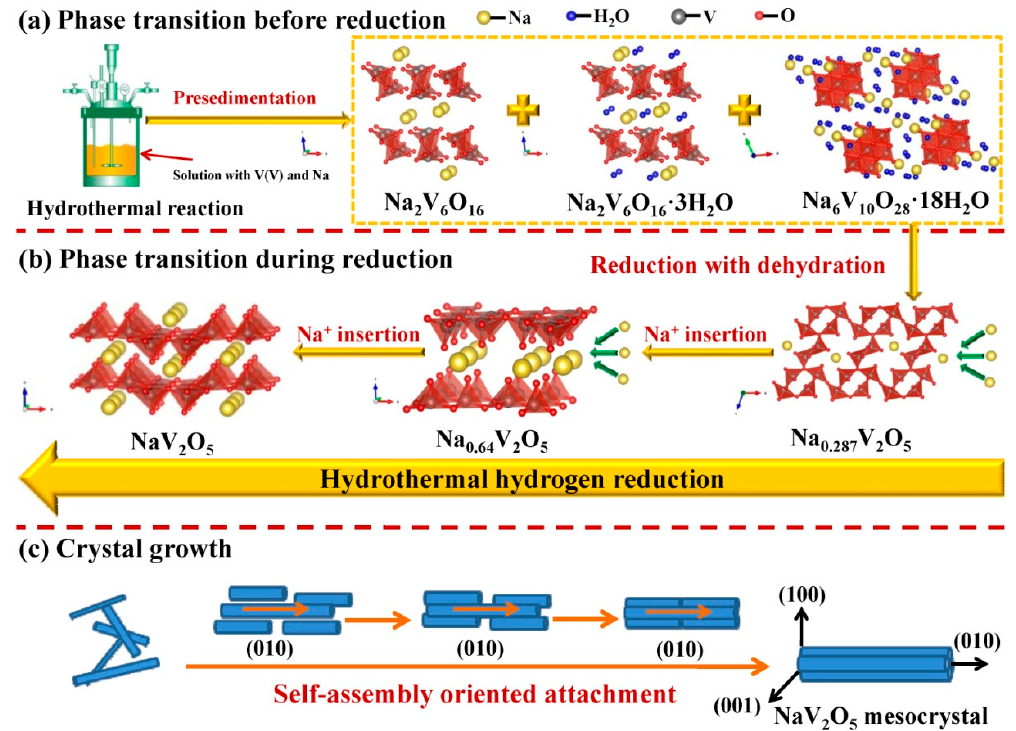
Figure 13. Schematic of the synthesis mechanism for rod-like NaV 2 O 5 mesocrystals. ( a ) The phase transition in the process of the formation of Na 2 V 6 O 16 · 3H 2 O, Na 6 V 10 O 28 · 18H 2 O, and Na 2 V 6 O 16 before the introduction of H 2 gas to the autoclave; ( b ) the phase transition mechanism in the formation of NaV 2 O 5 during the hydrothermal hydrogen reduction; ( c ) the crystal growth of rod-like NaV 2 O 5 mesocrystals follows a self-assembly oriented attachment mechanism.